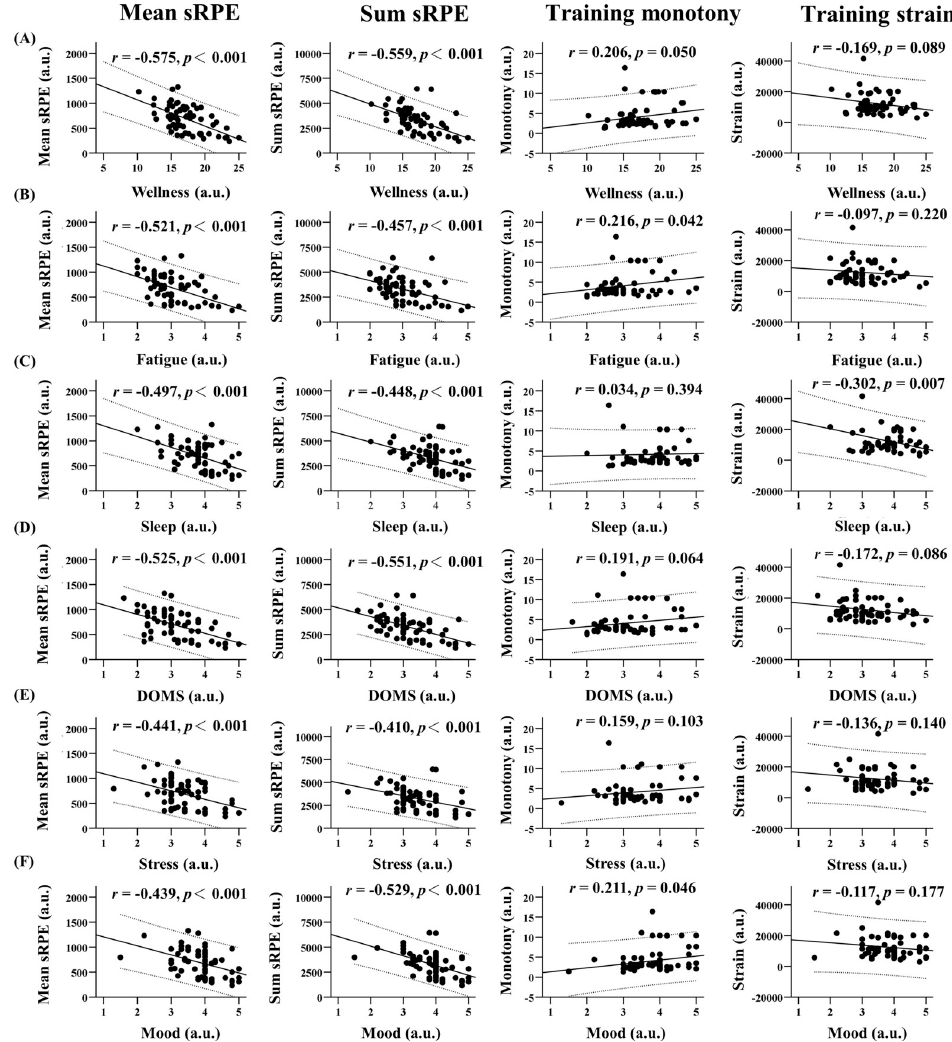
Fig 1. The linear regression analysis between perceived measures of internal loads and wellness status during futsal overseas training camps. Columns illustrate relationships between mean session rating of perceived exertion/ sum session rating of perceived exertion/ training monotony/training strain (from most left column to most right column in the continuous sequence) and all wellness components: A) relationship with wellness scores, B) relationship with fatigue, C) relationship with sleep, D) relationship with delayed onset muscle soreness, E) relationship with stress, F) relationship with